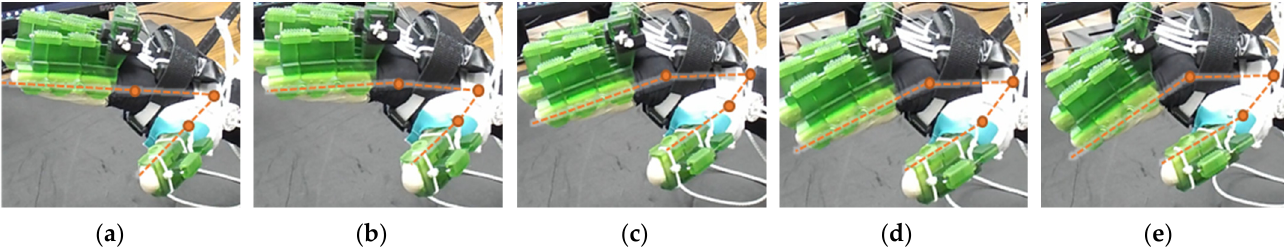
Figure 19. MCP flexion of fingers and thumb: ( a ) fingers and thumb are at the extended position, MCP joint angle: 0°; ( b – d ) intermediate MCP joint positions; and ( e ) fingers and thumb are at flexed, MCP joint angle, fingers: 55–57° and thumb: 25°.